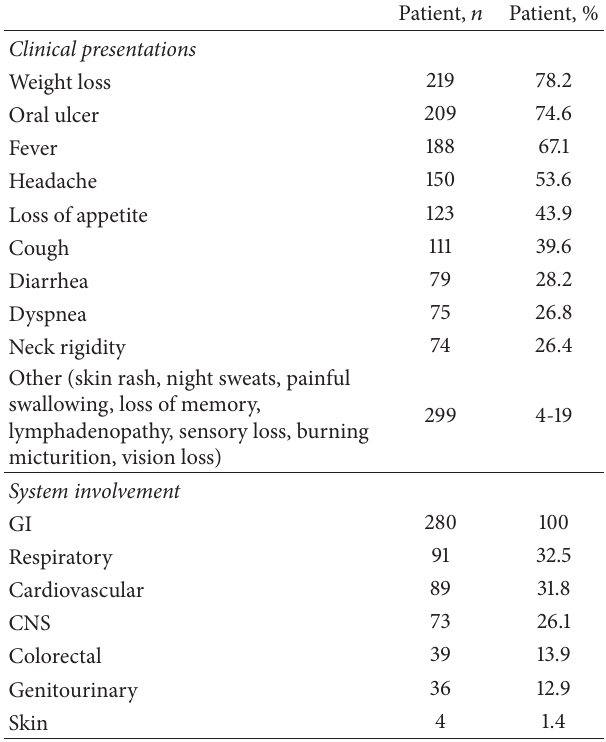
Table 2: Frequency of clinical presentations and system involve- ment in